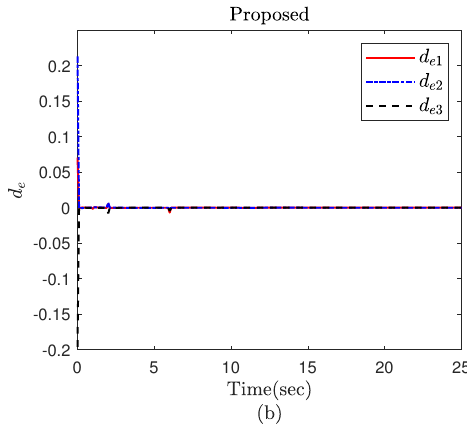
Figure 15. The estimation error in Part 3.